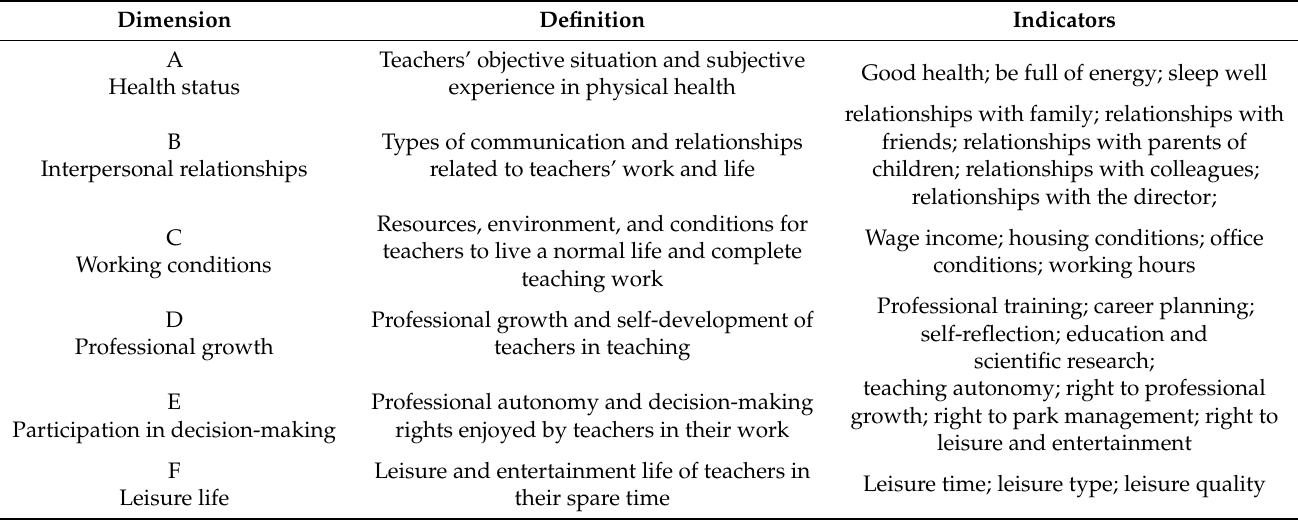
Table A1. Quality of work life scale for kindergarten